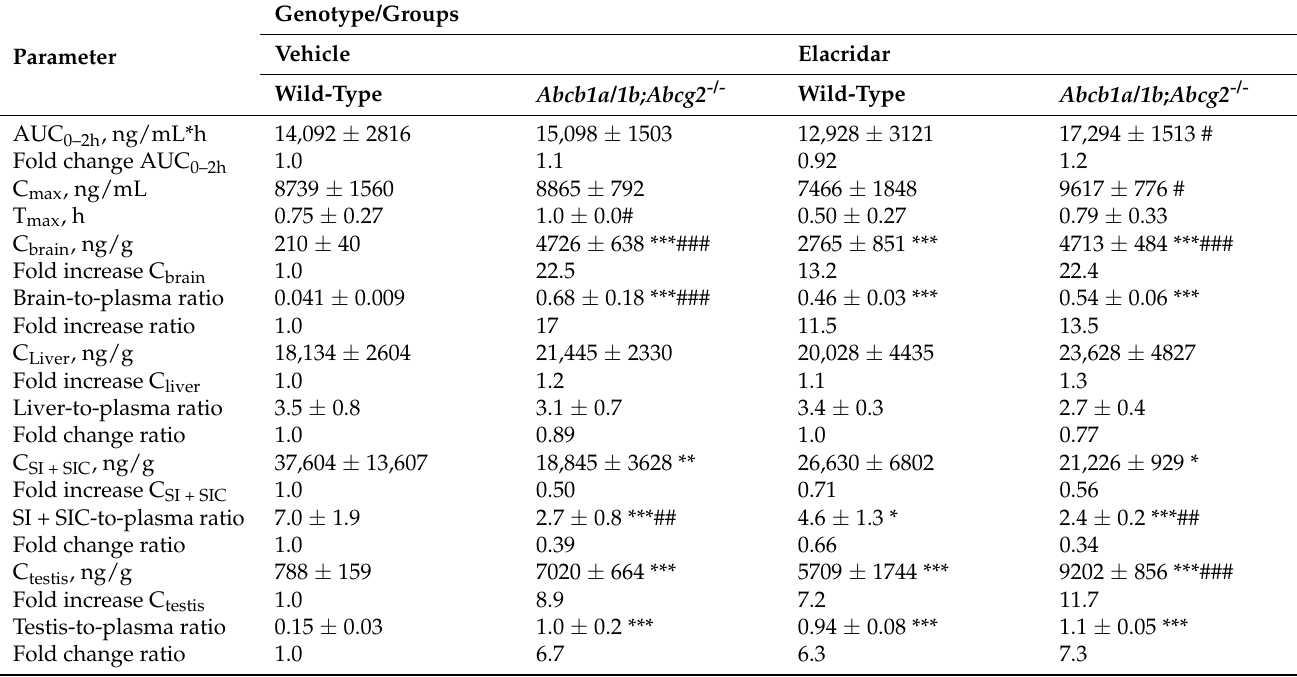
Table 3. Plasma and organ pharmacokinetic parameters of selpercatinib in male wild-type and Abcb1a/1b; Abcg2 -/- mice over 2 h after oral administration of 10 mg/kg selpercatinib with or without elacridar.